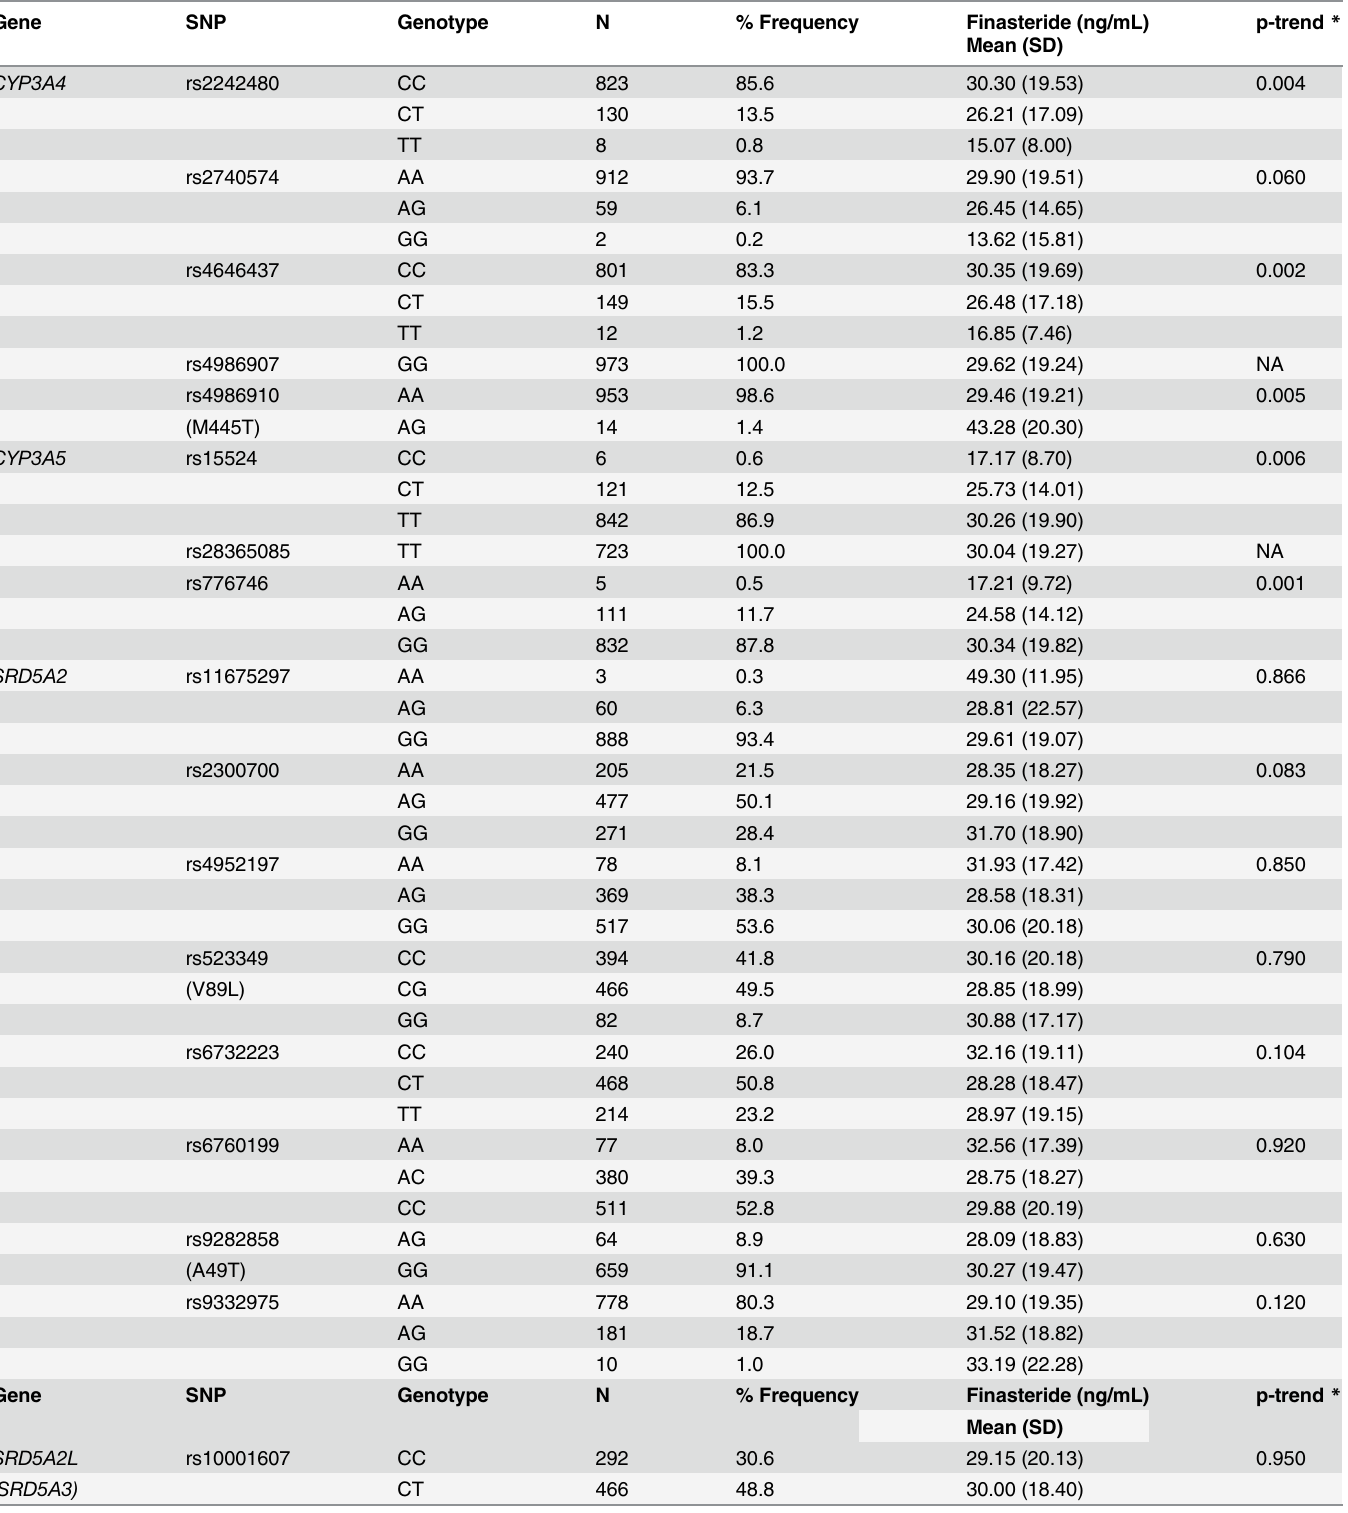
Table 4. Association between finasteride concentrations and genes in metabolism and target pathways among white men. #